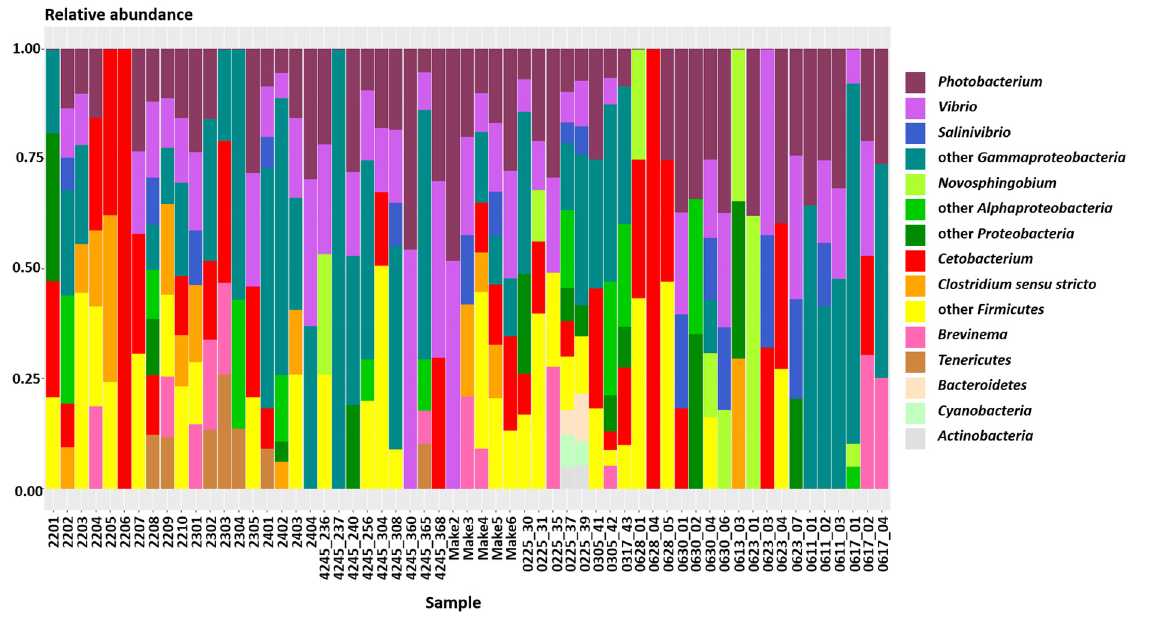
Figure 2. Relative abundance of the bacterial composition of individual samples. Each column represents a shark number. Colors in a column represent the proportion of each bacterial group.